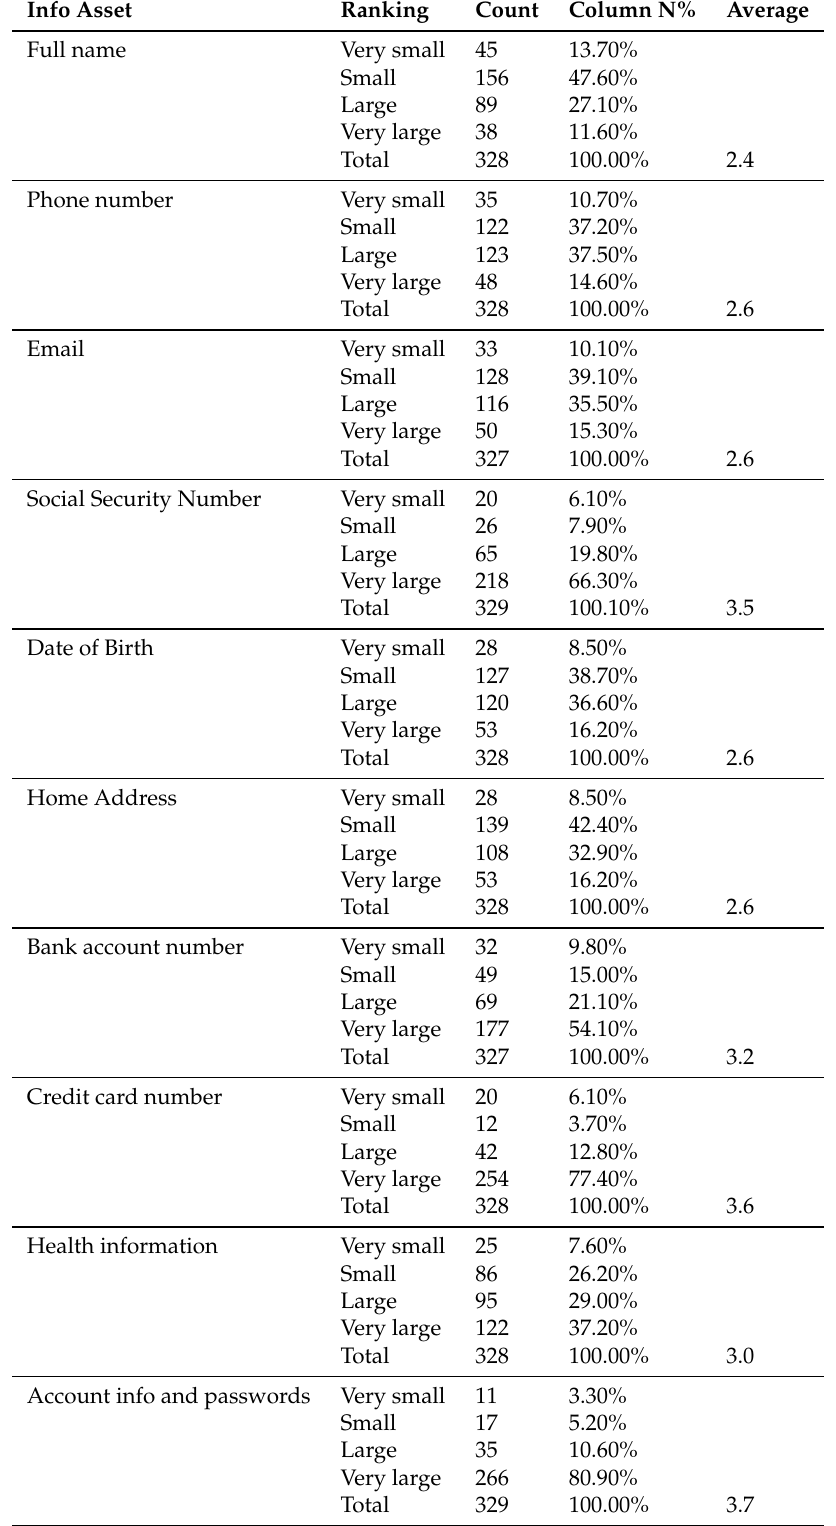
Table 19. “To what degree do you think that your shared information can be abused in an ID theft?” N =